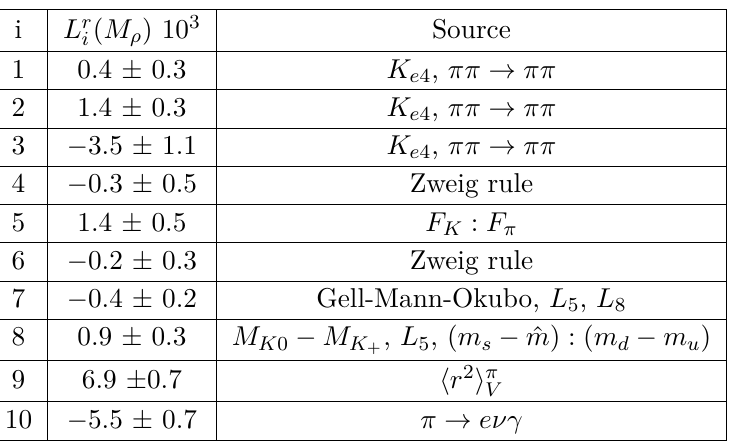
( M ) of (4.22) [7]. Last ρ i